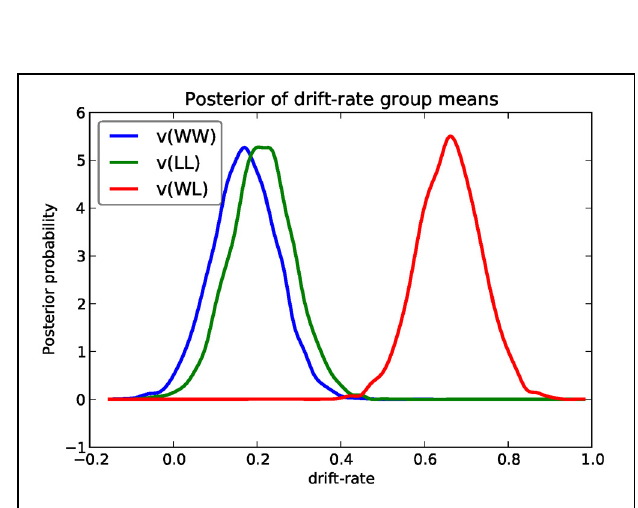
FIGURE 4 | Posterior density plot of the group means of the 3 different drift-rates v as produced by the hddm.analyze.plot_posterior_nodes() function. Regions of high probability are more credible than those of low